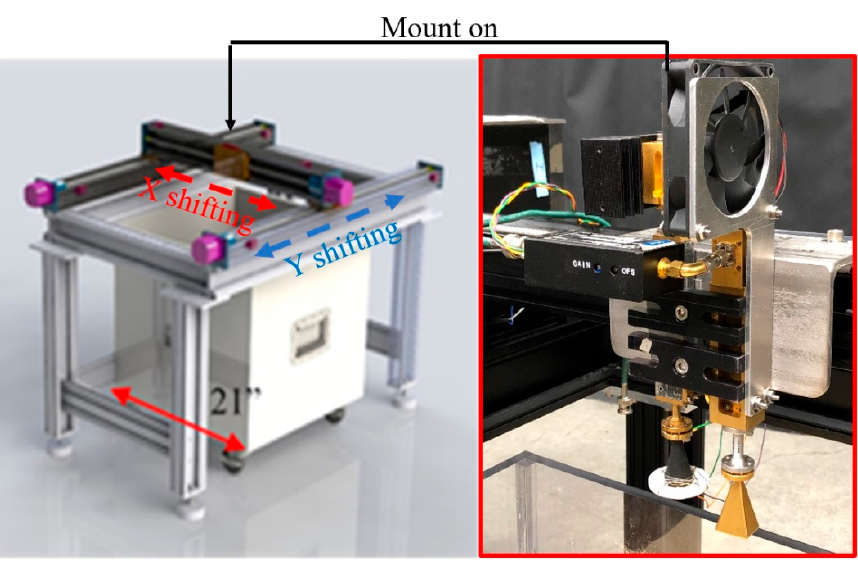
Figure 7. Swept-FM 2D-scan imaging system.